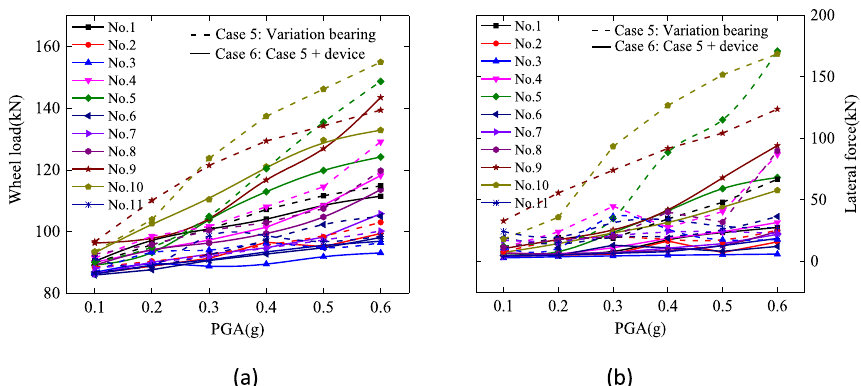
Fig. 20 IDA results of wheel-rail force with different constraint conditions: a wheel load; and b lateral